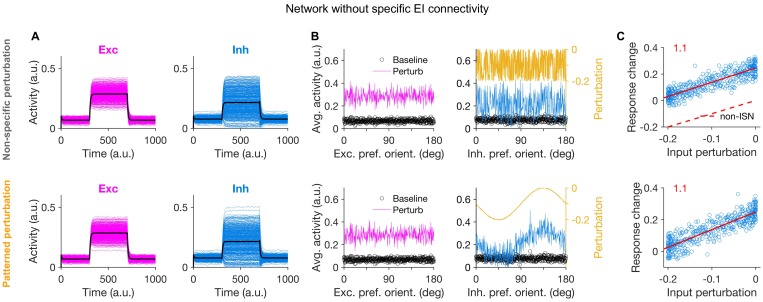
Lack of specific paradoxical effect in networks without specific EI connectivity.(A-C) Similar plots as in Figure 2A-C, respectively, for neuronal networks without feature-specific EI connectivity. Here, both nonspecific and patterned perturbation fail to yield a specific paradoxical effect (as quantified by lack of negative slopes in C), consistent with lack of specific ISNs in networks without specific connectivity. Note that the nonspecific paradoxical effect is still present, as reflected in the increase in the average activity of inhibitory neurons despite negative perturbations.